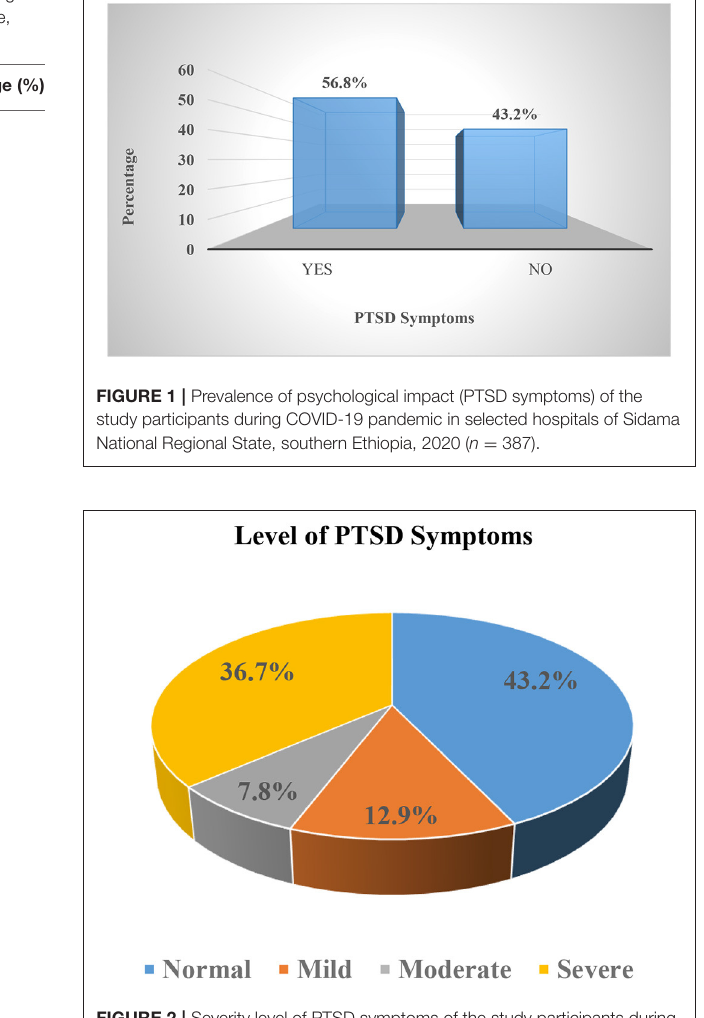
FIGURE 2 | Severity level of PTSD symptoms of the study participants during COVID-19 pandemic in selected hospitals of Sidama National Regional State, southern Ethiopia, 2020 ( n =